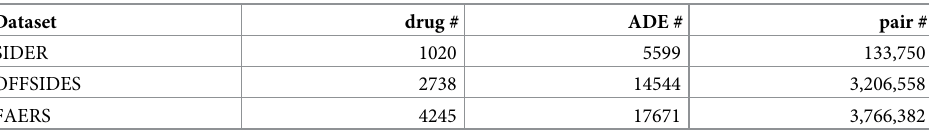
Table 1. Statistics of adverse drug event association pairs in three datasets.